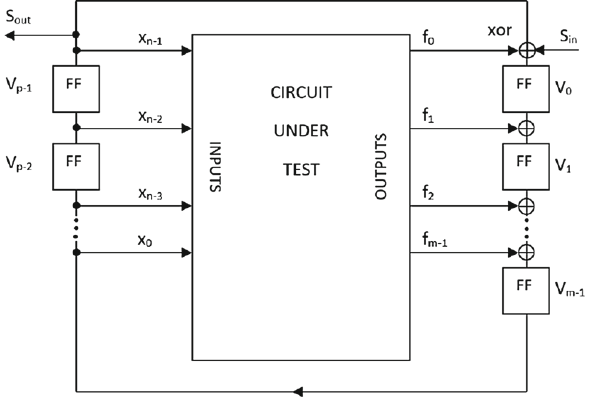
Fig. 2 Circular self-test path model